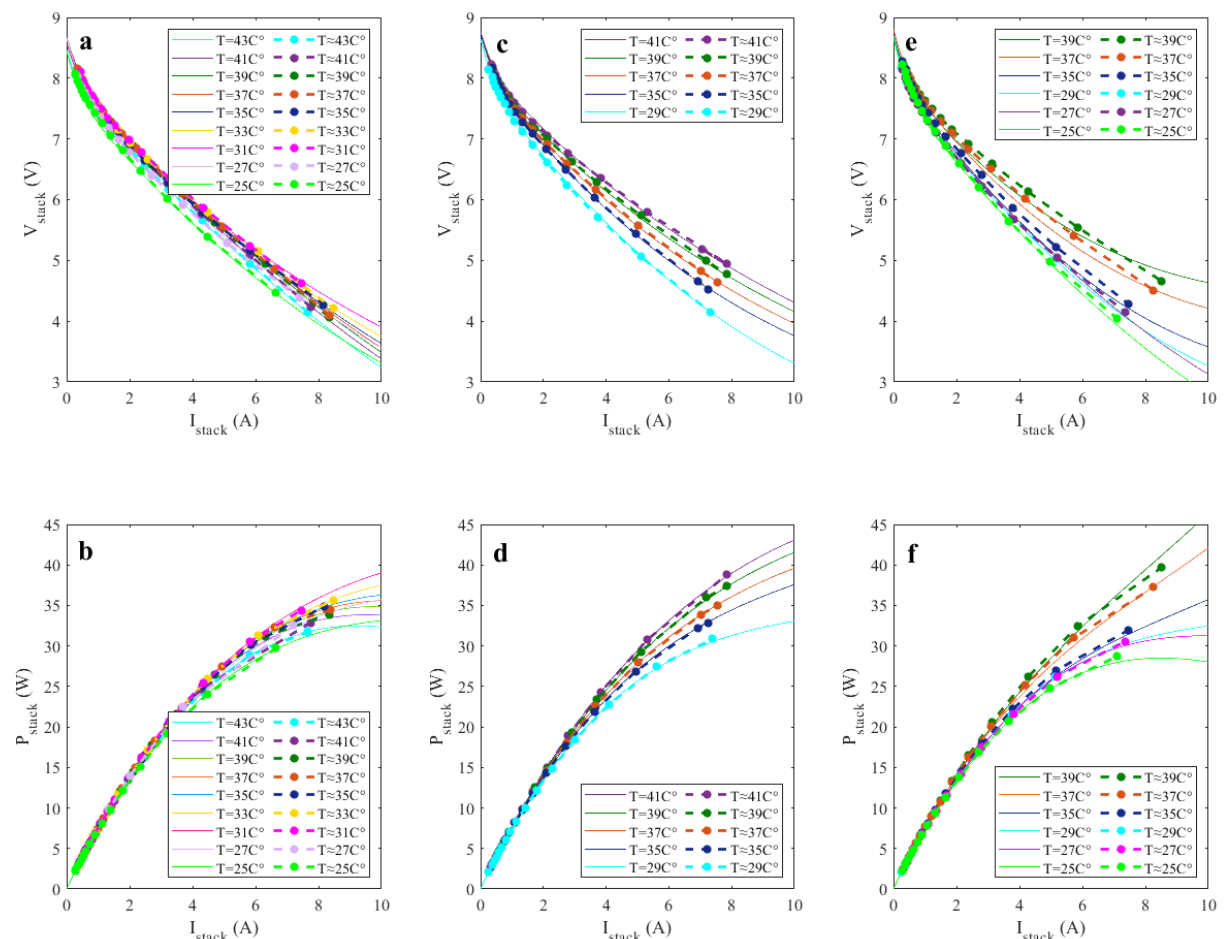
Figure 11. Simulation and experiment results (simulation: continuous line; experiment: dashed line); ( a ): I stack - V stack polarisation curves when Fans Power = 10%; ( b ): I stack - P stack polarisation curves when Fans Power = 10%; ( c ): I stack - V stack polarisation curves when Fans Power = 50%; ( d ): I stack - P stack polarisation curves when Fans Power = 50%; ( e ): I stack - V stack polarisation curves when Fans Power = 100%; ( f ): I stack - P stack polarisation curves when Fans Power =